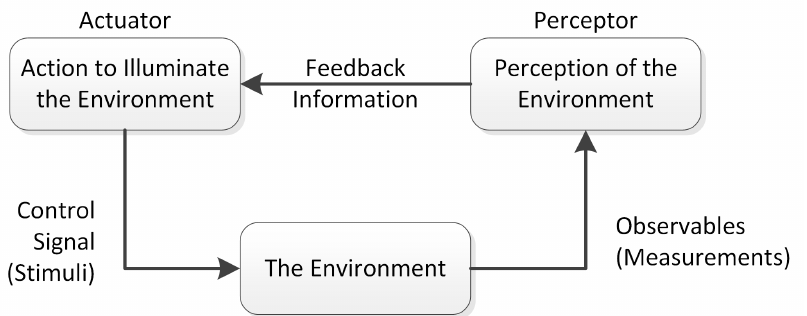
Figure 1. The perception-action cycle of a cognitive dynamic system in its most generic sense. Reprinted with permission from Cambridge, 2012